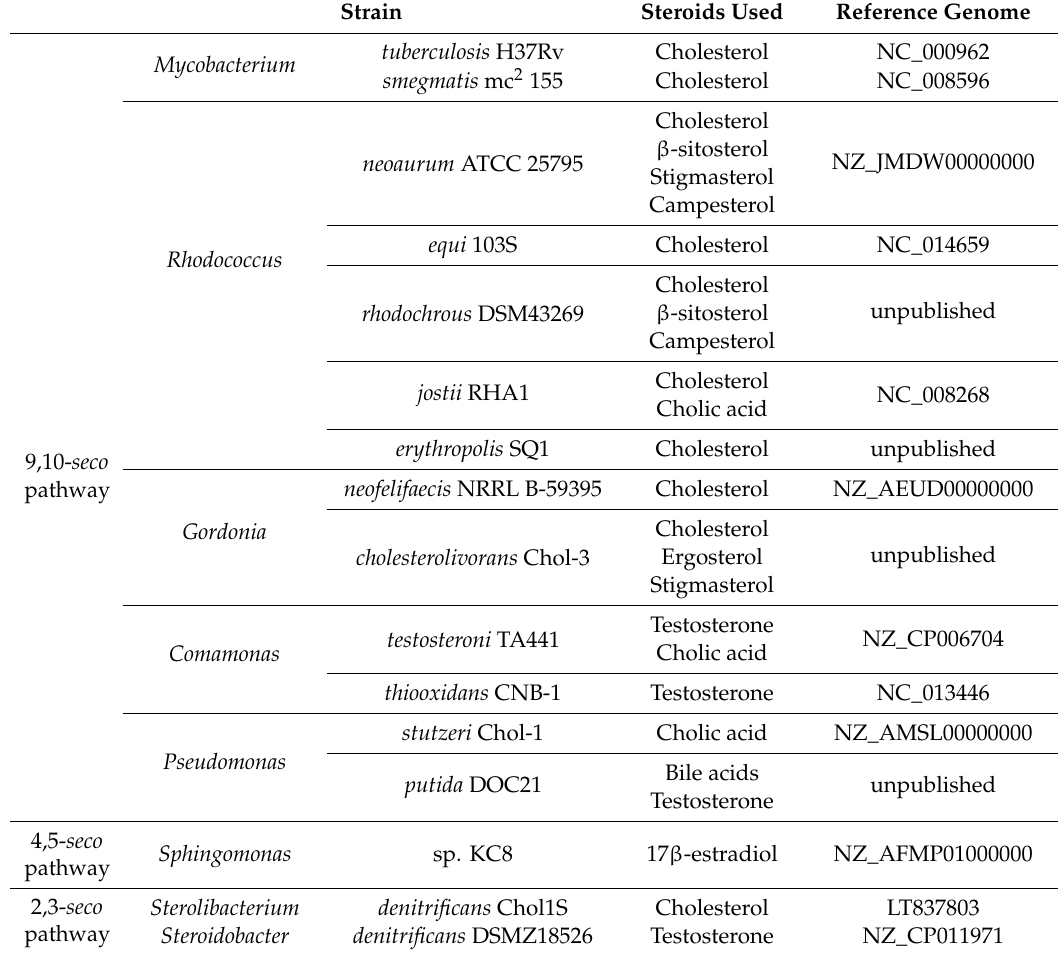
Table 1. Model strains widely used in the studies that have allowed the characterization of the metabolic mechanisms used for steroid degradation. Steroids used in these studies are also